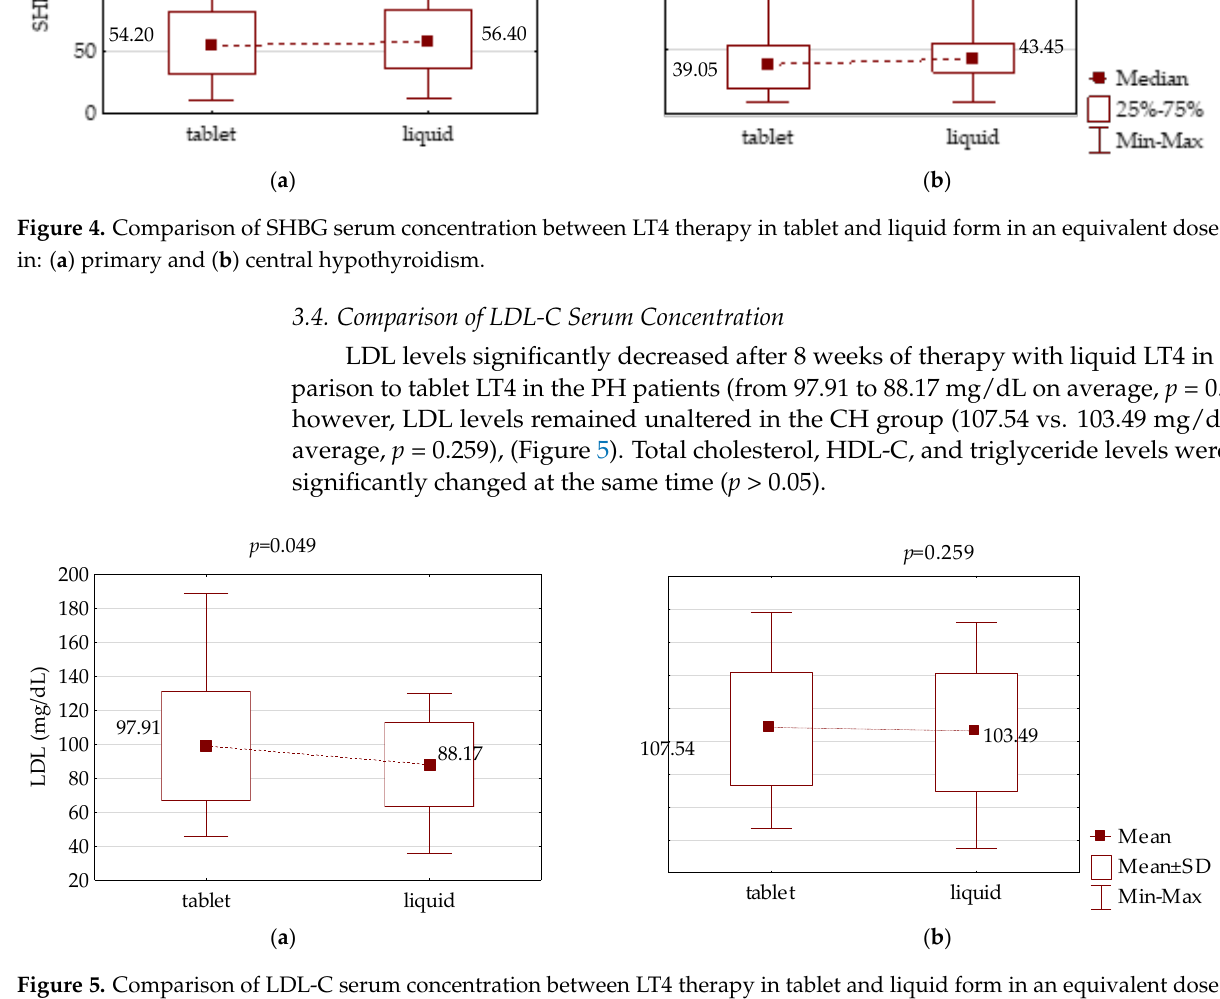
Table 2. Comparison of QoL (ThyPROpl) between LT4 therapy in tablet and liquid form in an equivalent dose in primary and central hypothyroidism.